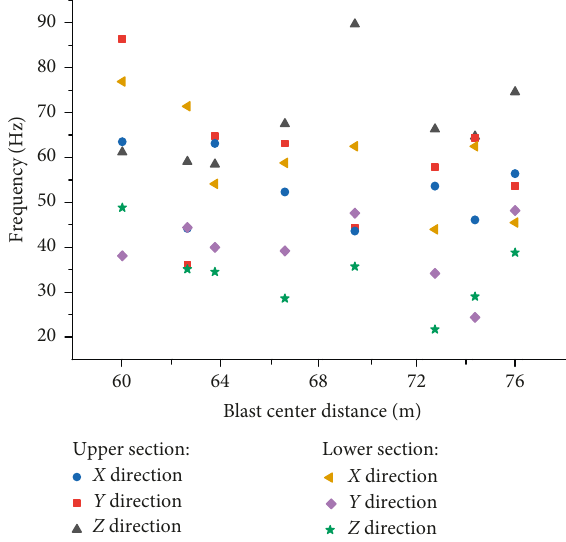
Figure 15: Distribution of the main frequency with the blast center distance of the upper and lower